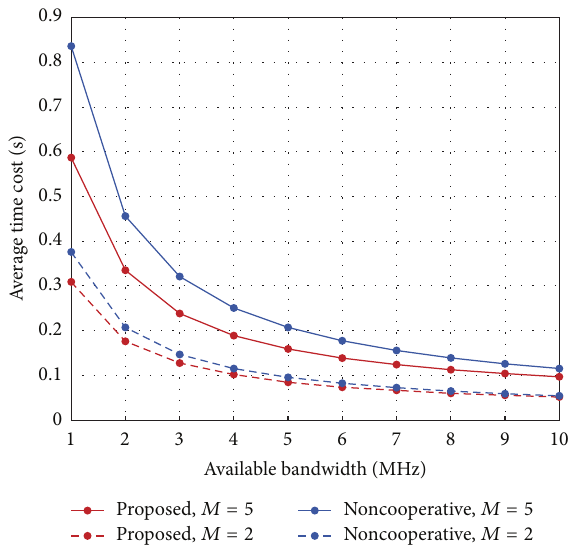
Figure 2: The average time cost performance ( 𝑇 𝑗 , 𝑇 different number of DANs ( 𝑀 𝑗 ) with different cluster locations ( 𝑑 = 100 m, 200 m).